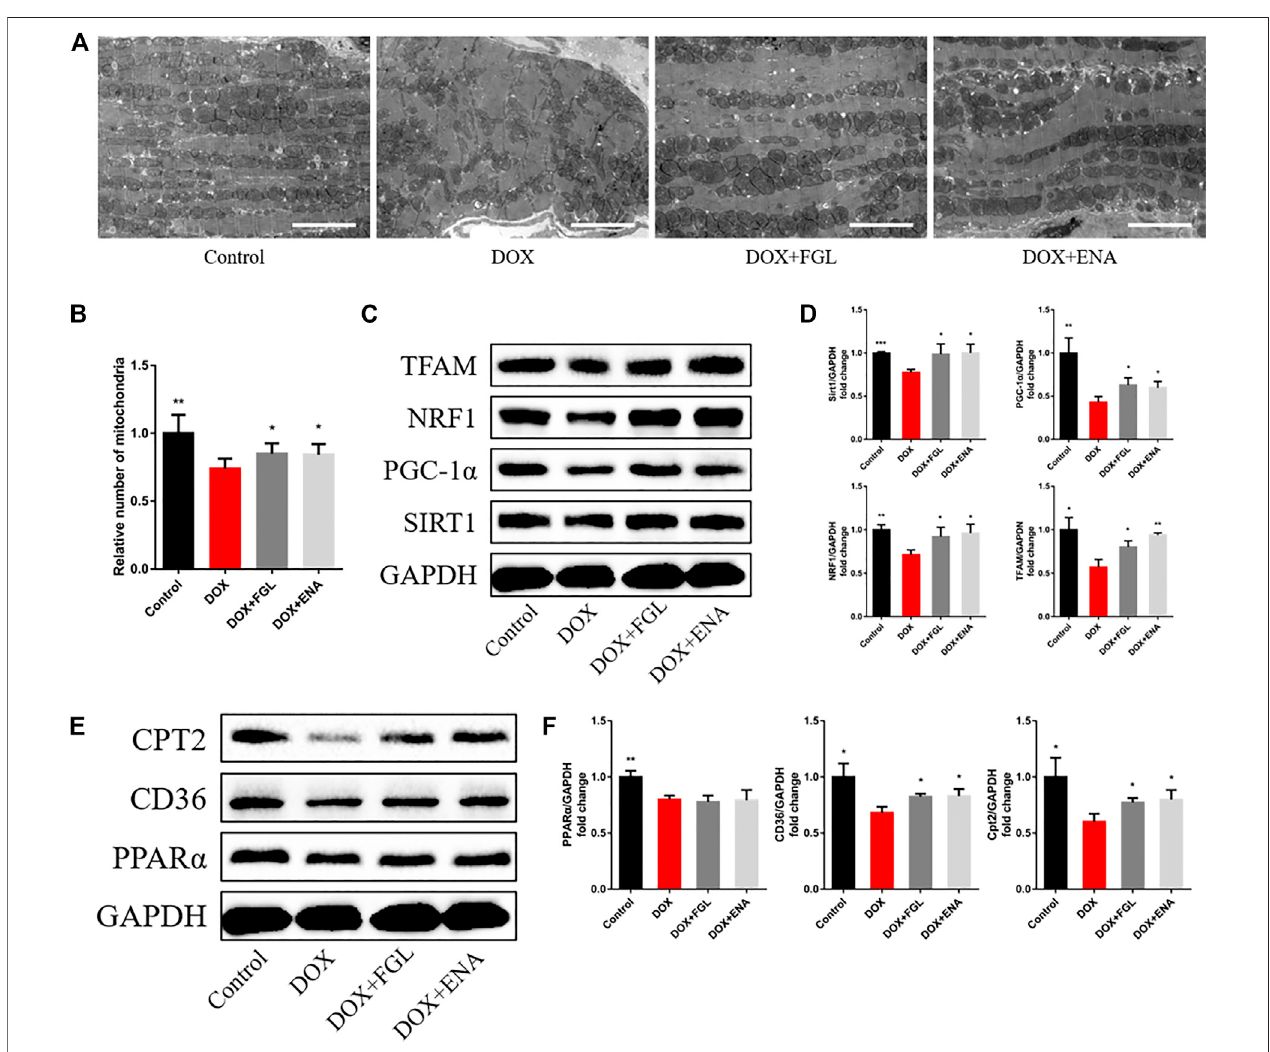
FIGURE 4 | FGL promoted mitochondrial biogenesis and fatty acid oxidization in vivo . (A, B) Representative images and quantitative analysis of electron micrographs of the heart (n (cid:2) 6). Scale bar: 5.0 μ m. (C – F) Expression levels of mitochondrial biogenesis and fatty acid oxidization-associated proteins were quanti fi ed and shown as relative protein expression levels after normalization to GAPDH (n (cid:2) 3 – 5). * p < 0.05, ** p < 0.01, *** p < 0.001 vs DOX group.